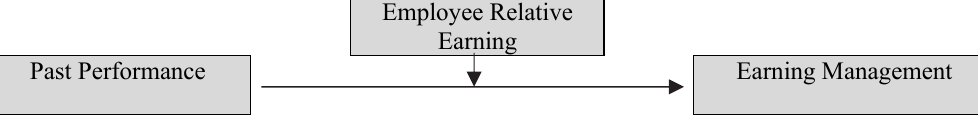
Fig. 1. The moderating effect of employee relative earning on the relationship between past performance and earning